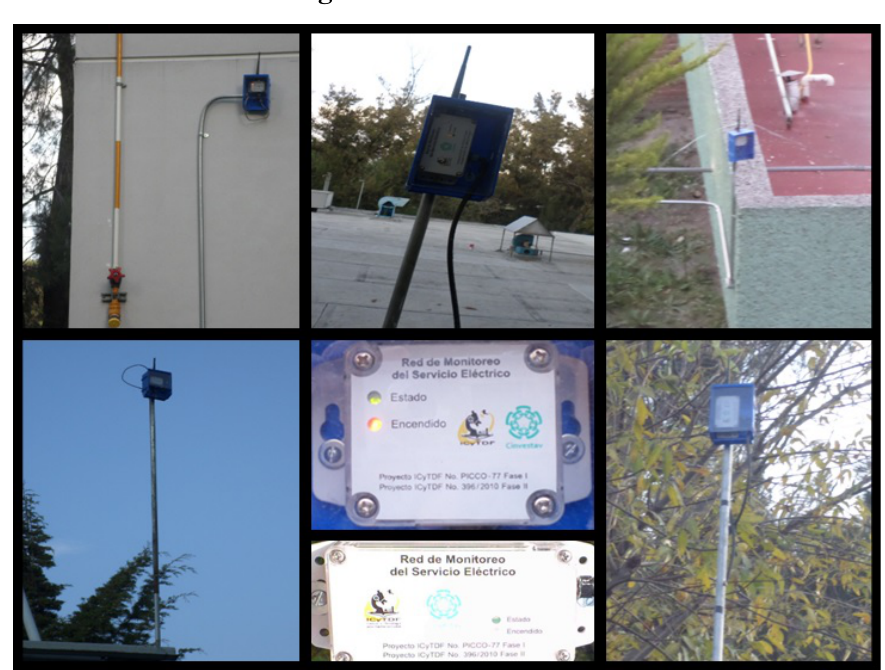
Figure 2. Wireless